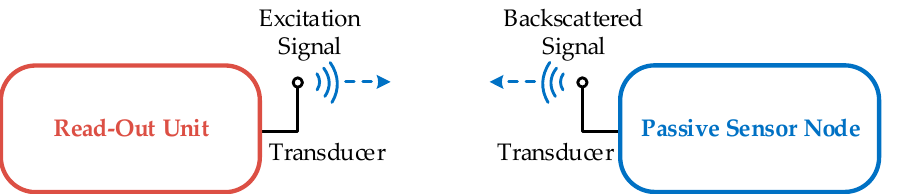
Excitation Backscattered Signal Signal Read-Out Unit Passive Sensor Node Transducer Transducer Figure 1. Schematic of a wireless passive sensor system: A readout unit sends out an excitation signal via a transducer into a wireless channel to a passive sensor node. There, this signal is picked up with the help of the transducer and stored in a high-Q resonator. When the excitation signal is turned off, the resonator rings out with its natural frequency and sends out a backscattered signal, which is picked up by the readout unit and